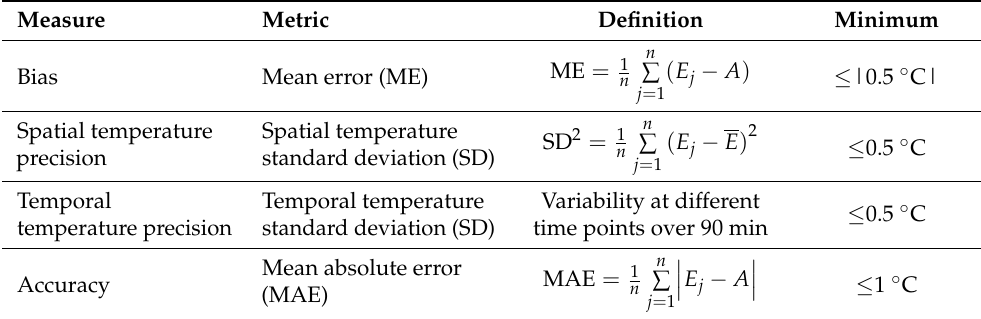
Table 2. Minimum performance metrics for successful MRT in hyperthermia treatments. Measure Metric